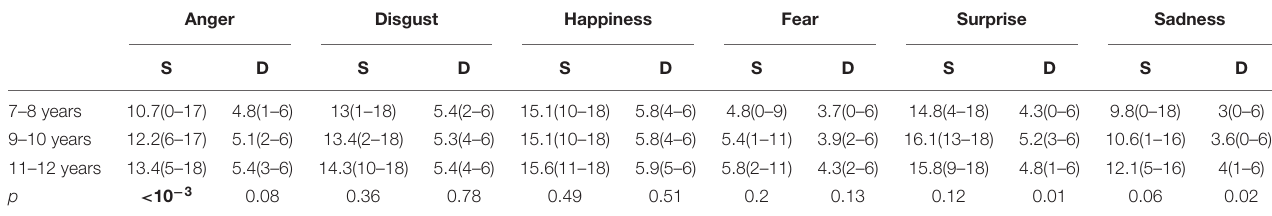
FIGURE 4 | Mean, minimum and maximum of scores according to each emotion on the dynamic subtest. TABLE 4 | Distribution of the mean score of the emotions of the static and dynamic subtest according to age groups. Anger Disgust